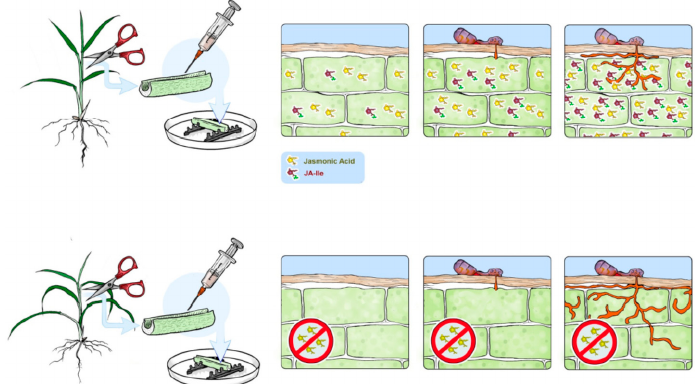
Figure 3. Function of JA in incompatible interaction of rice and Magnaporthe oryzae . Leaf sheath segments of rice plants were inoculated with an incompatible strain of Magnaporthe oryzae . The wild type (WT) produces JA and JA-Ile, probably in response to appressorium penetration. Dependent on the production of JA-Ile, the plant produces phytoalexins such as sakuranetin, momilactones and phytocassanes. The mutant cpm2 and hebiba , which are impaired in JA biosynthesis, do not accumulate sakuranetin and less momilactones. Correlating with lower JA-Ile and sakuranetin levels, fungal hyphae spread more easily in the